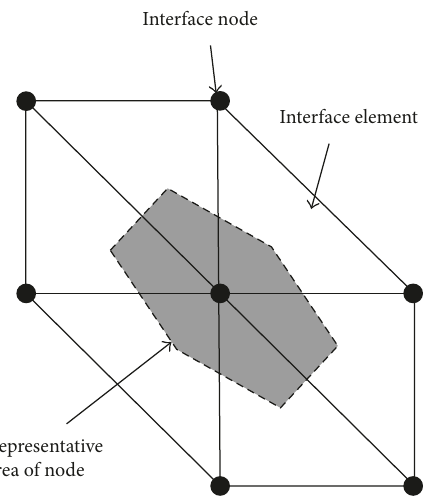
Figure 1: Interface element of Flac 3D